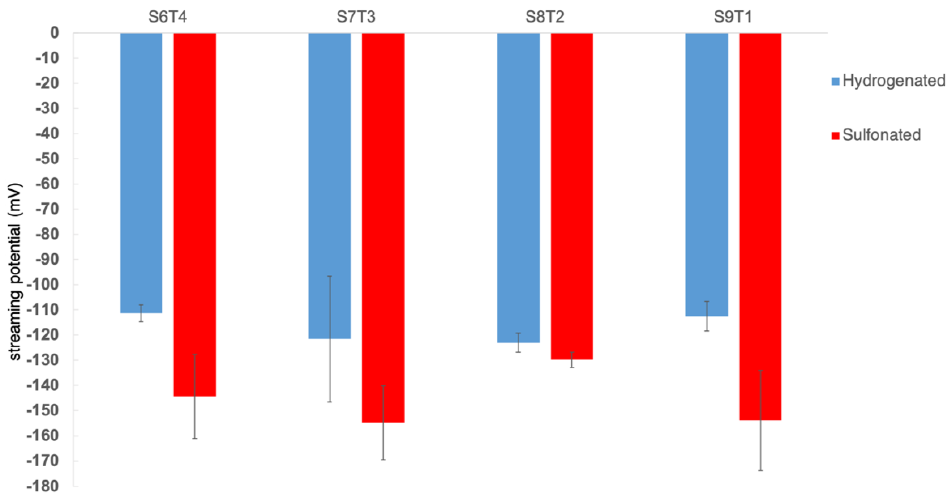
Figure 5. Streaming potential of the hydrogenated and sulfonated hydrogenated SIS samples.